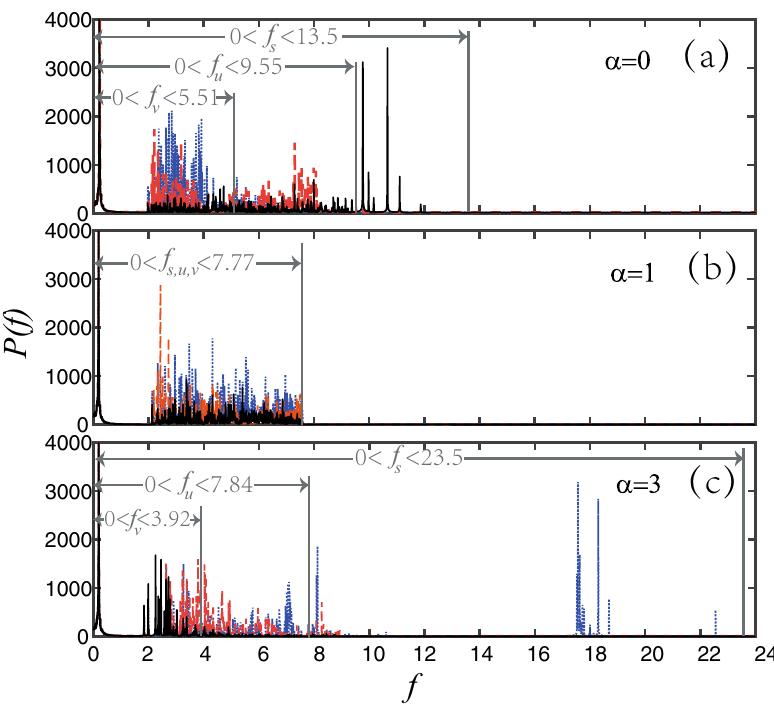
Figure 8. Power spectra of the time series in Fig. 6a–c where the black solid line, red dash line and blue dot line correspond to the nodes s , u and v , respectively. The width of grey arrows is the theoretical result by Eq. (13). The other parameters are the same as in Fig.